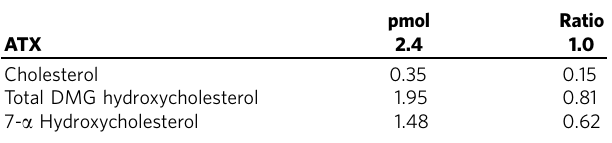
Table 2 | Mass spectrometry analysis of